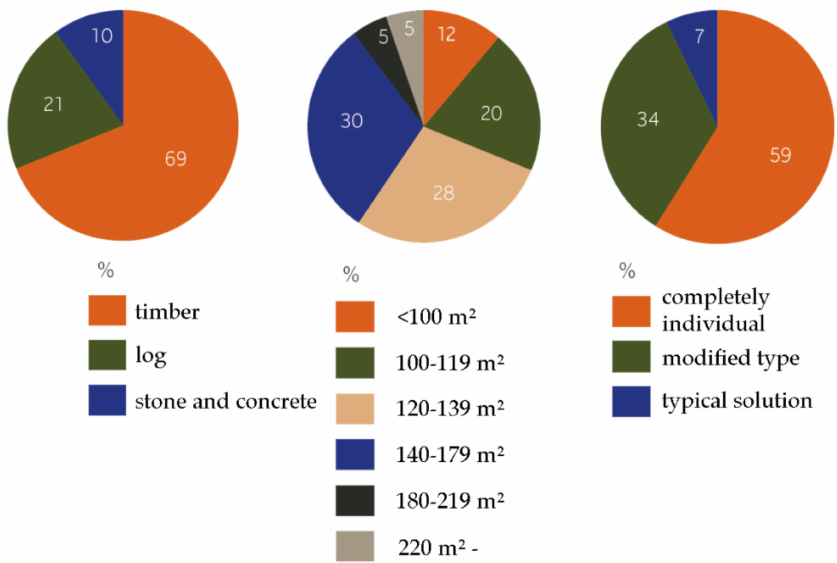
Figure 4. Small house construction in 2021 in Finland by frame material, size, and modi- fied/customized